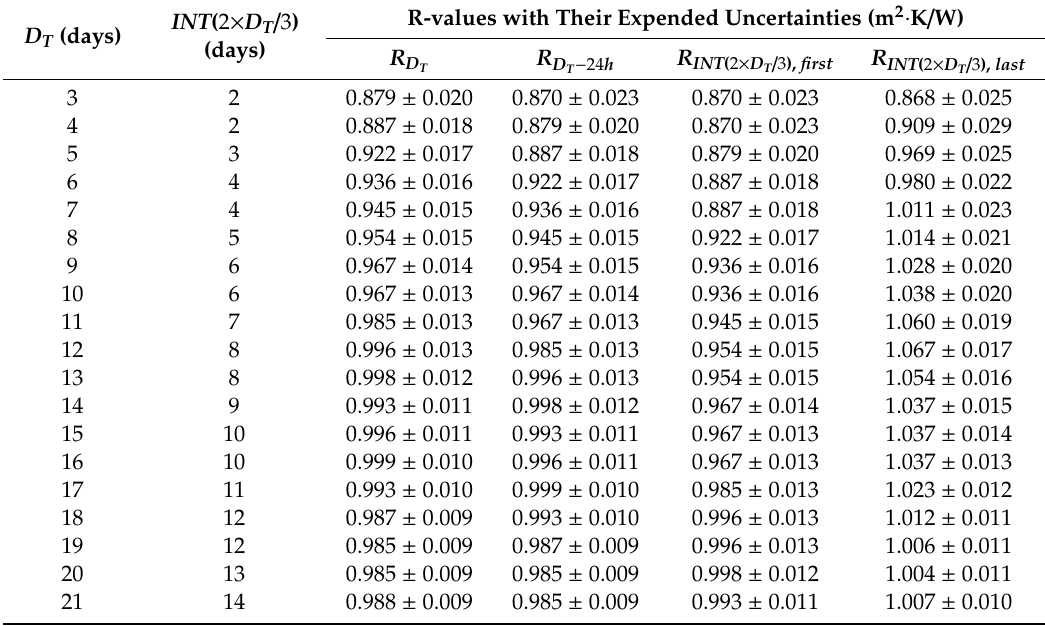
Table 4. R -values analyzed by average method and their expanded uncertainties.